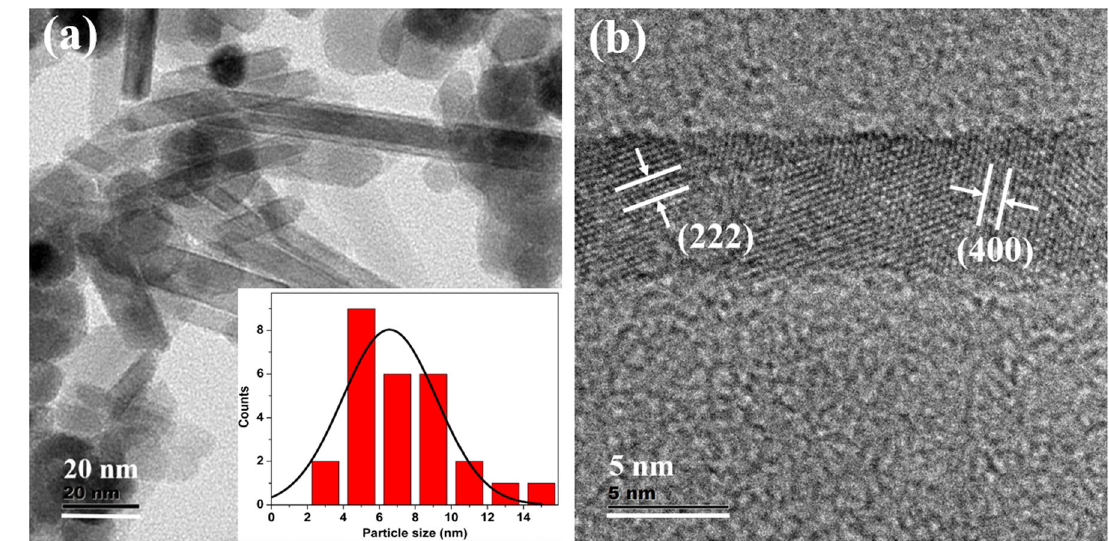
Fig. 3 a TEM image of iron oxide nanoparticles with spherical and rod-shaped morphology (Fe 3 O 4 ). The inset shows the average diameter of nanorods and b HRTEM image of nanorod iron